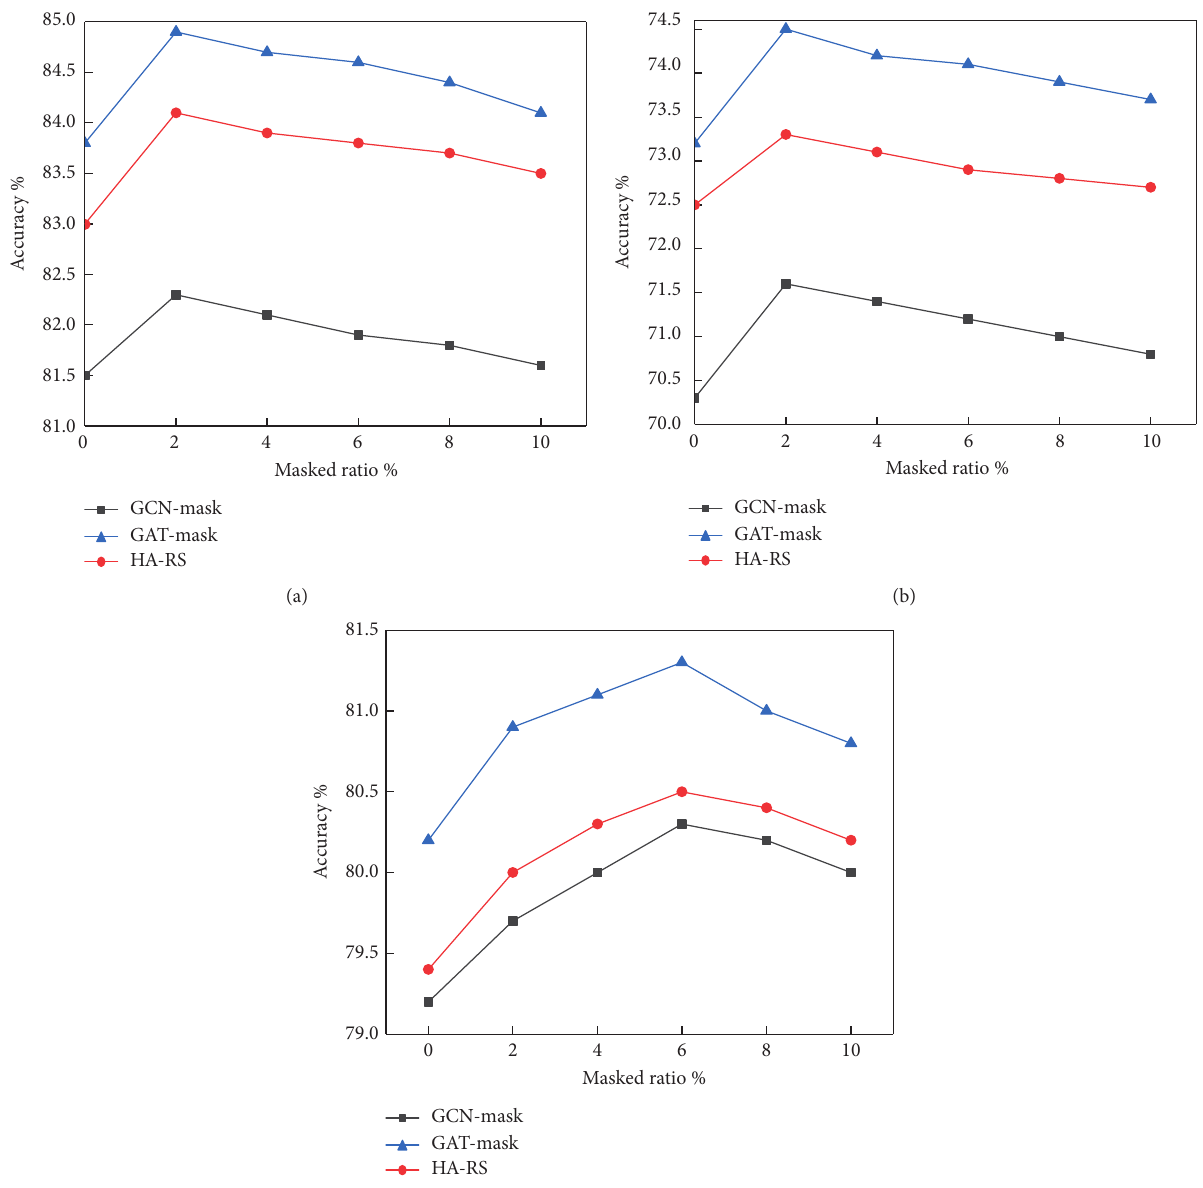
Figure 5: Results of different masked ratios on the citation dataset. (a) Cora dataset. (b) CiteSeer dataset. (c) PubMed